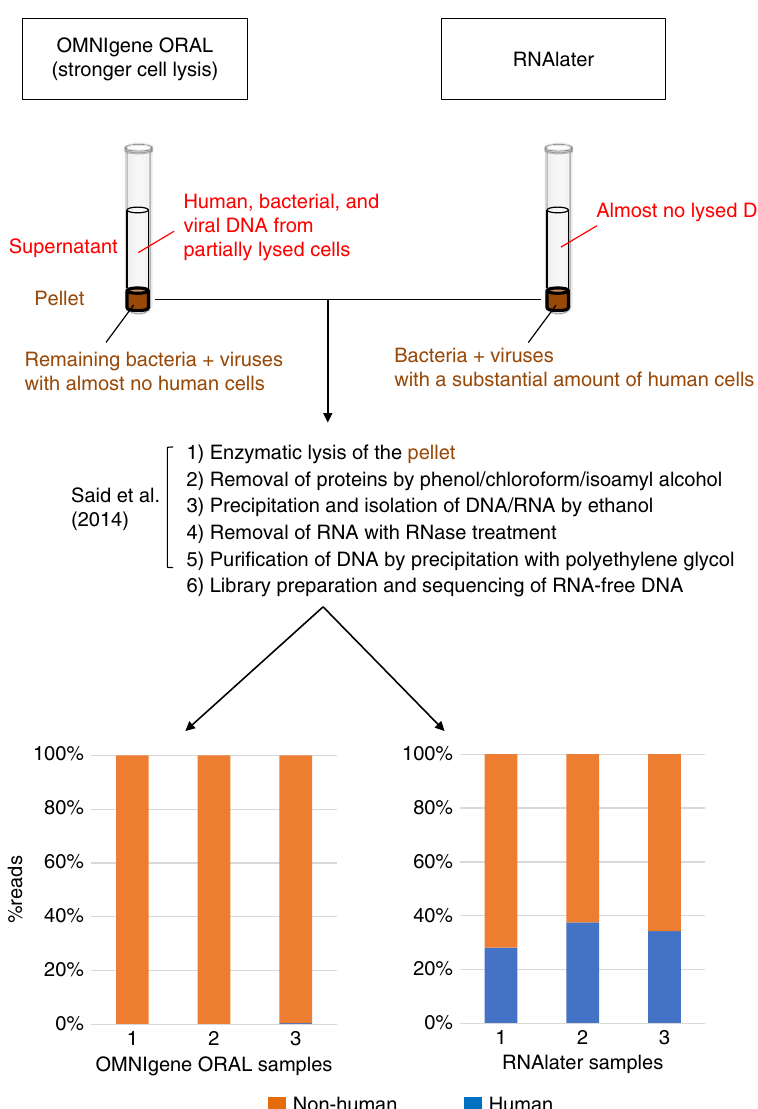
Fig. 1 Reduction of human reads using the OMNIgene ORAL kit followed by enzymatic DNA extraction. The scheme at the top outlines the protocol used for DNA collection and extraction and depicts the different constituents of the supernatant and pellet, their separation by centrifugation before enzymatic lysis, and the key steps of the DNA extraction procedure. The bar graph at the bottom shows the percentage of human reads (blue) and non- human reads (orange) present in the three samples stored using OMNIgene ORAL (left) or RNA later